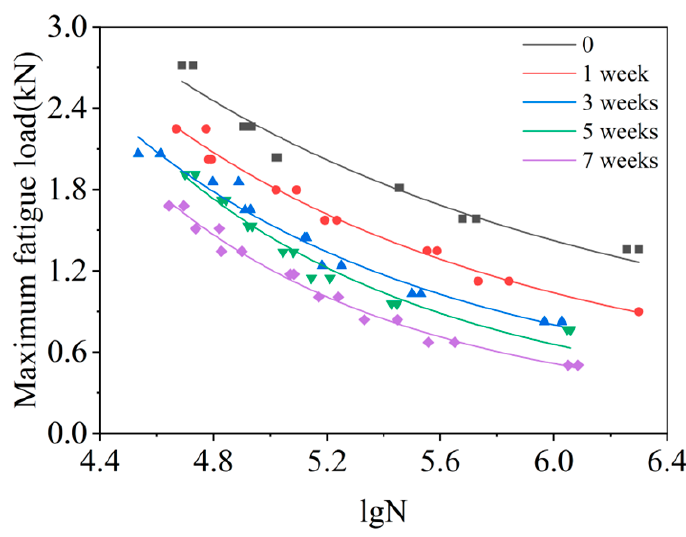
Figure 9. Load-life (F-N) curves of the SPR joints at different SSC durations.